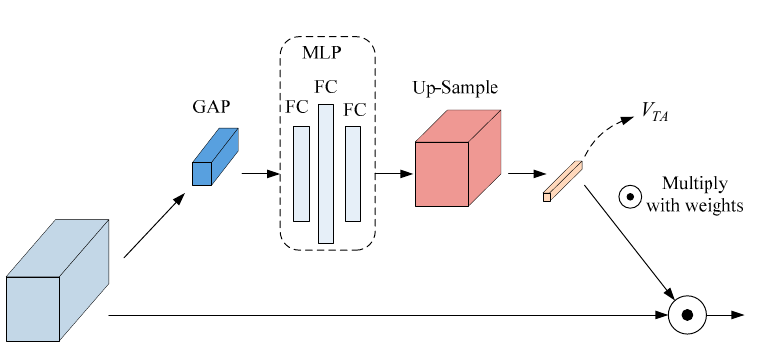
Figure 4. Temporal A tt ention Former Block (TACB).